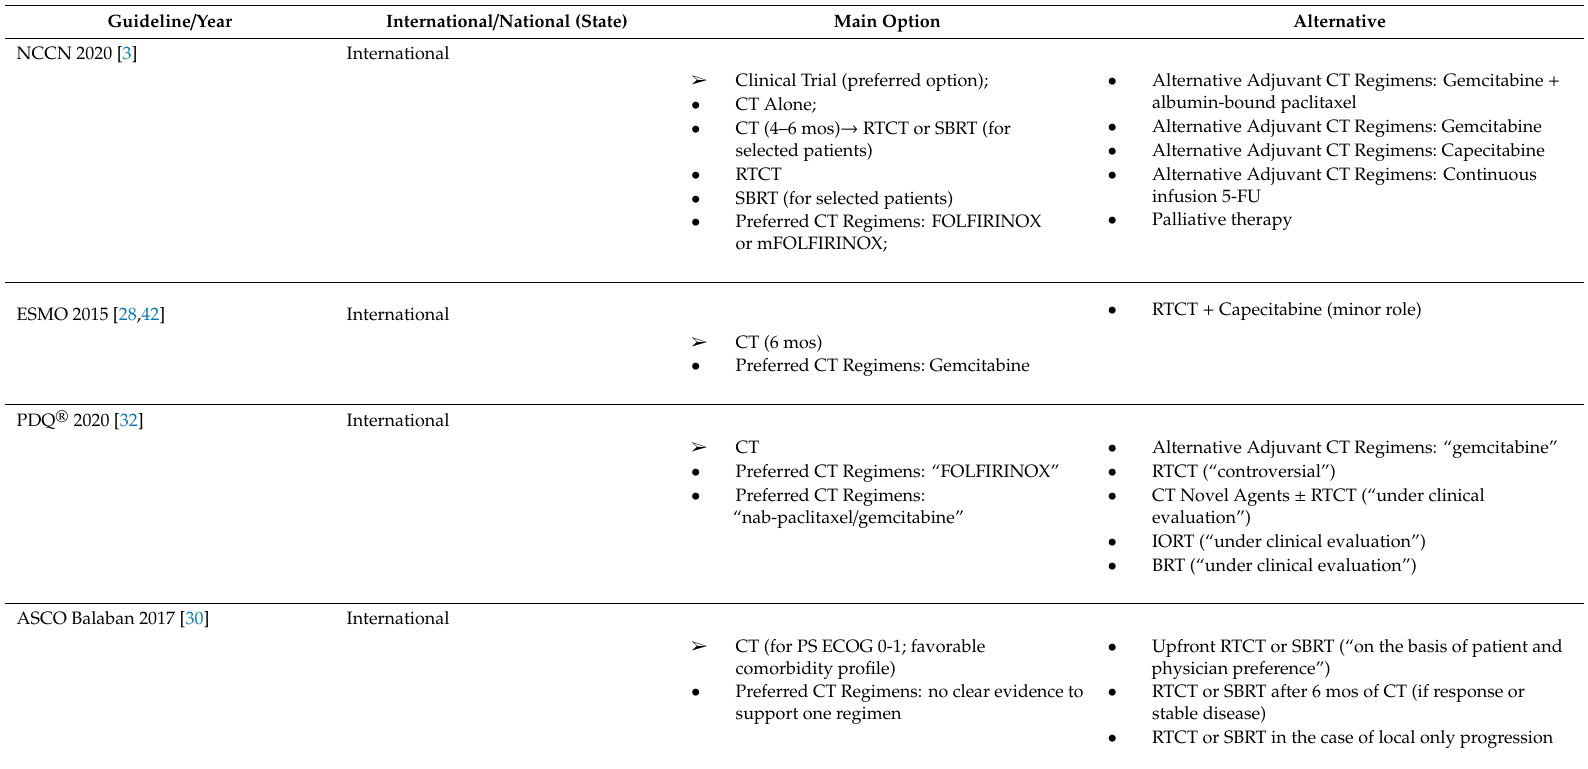
Table 2. Clinical presentation: Locally Advanced Pancreatic Cancer